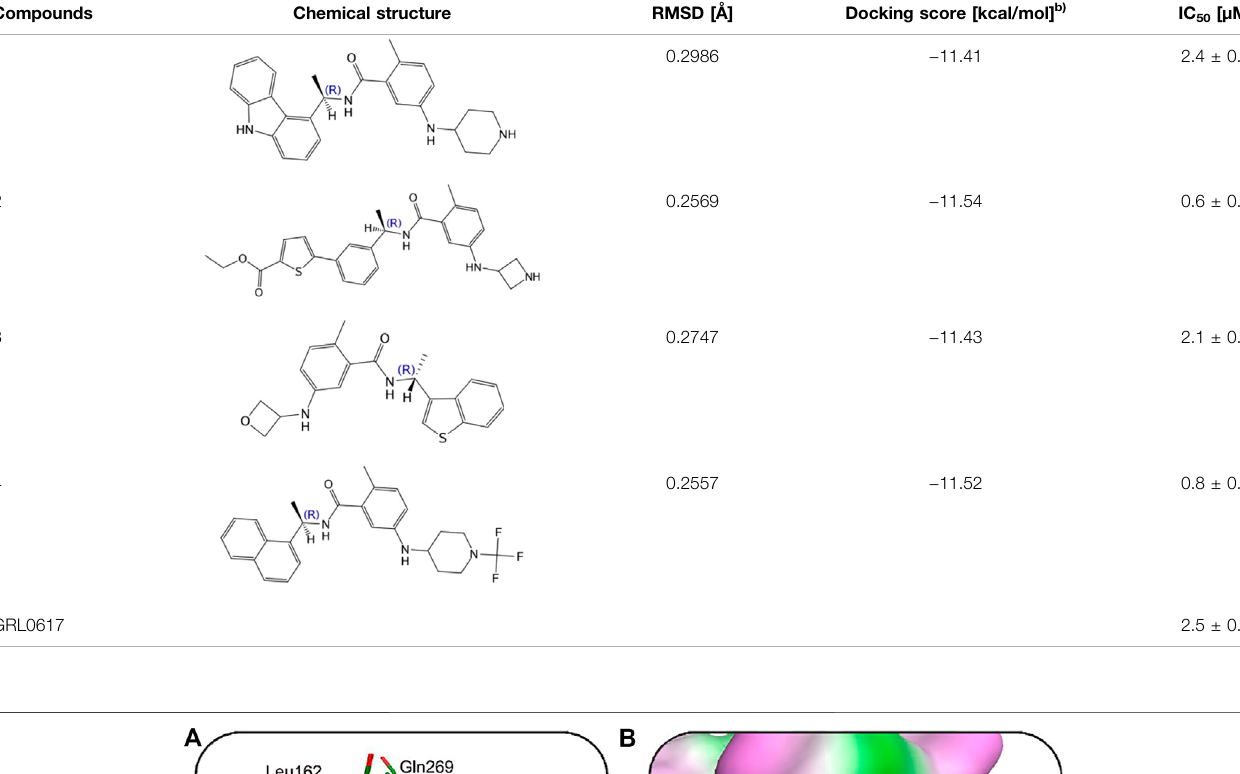
TABLE 4 | Hit compounds selected from an in-house database. Compounds